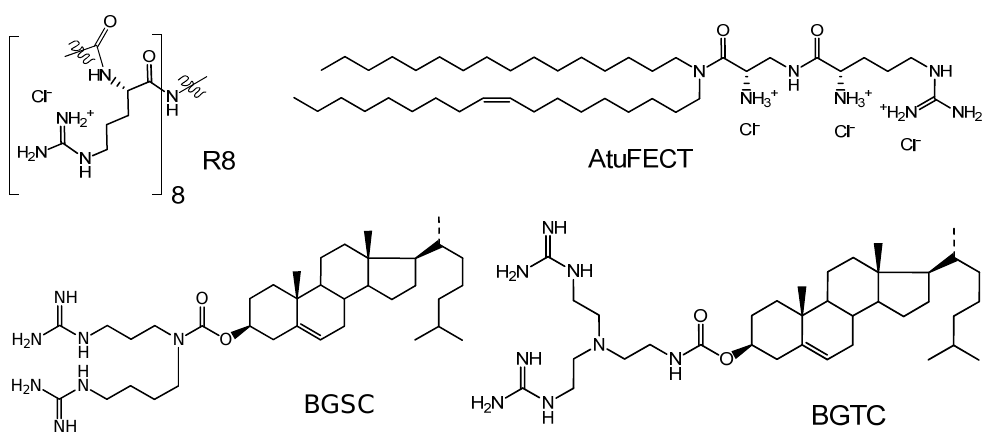
Figure 1. Some guanidines used in delivery of genes and other